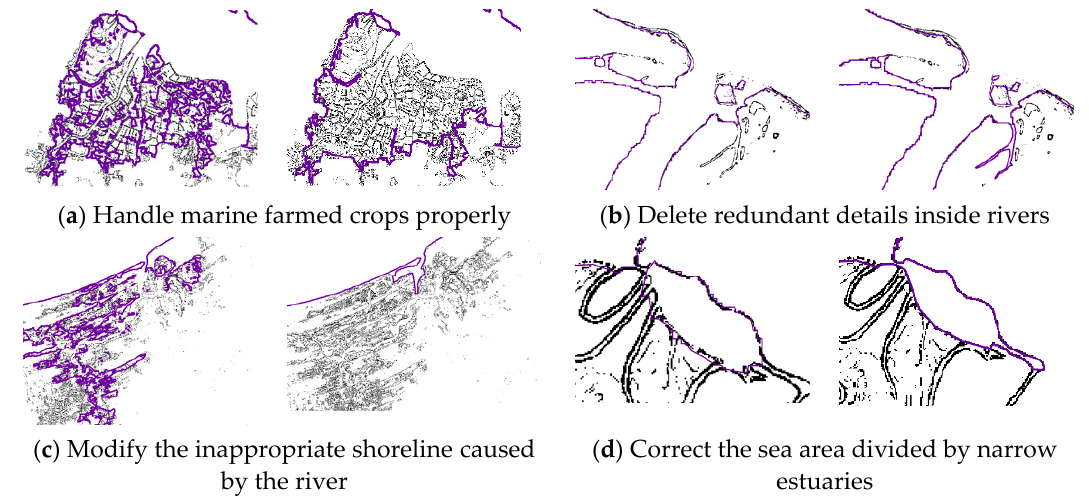
Figure 6. Schematic diagram of comparison before and after shoreline processing. ( a ) before and after handling marine farmed crops properly; ( b ) before and after deleting redundant details inside rivers; ( c ) before and after modifying the inappropriate shoreline caused by the river; and ( d ) before and after correcting the sea area divided by narrow estuaries.